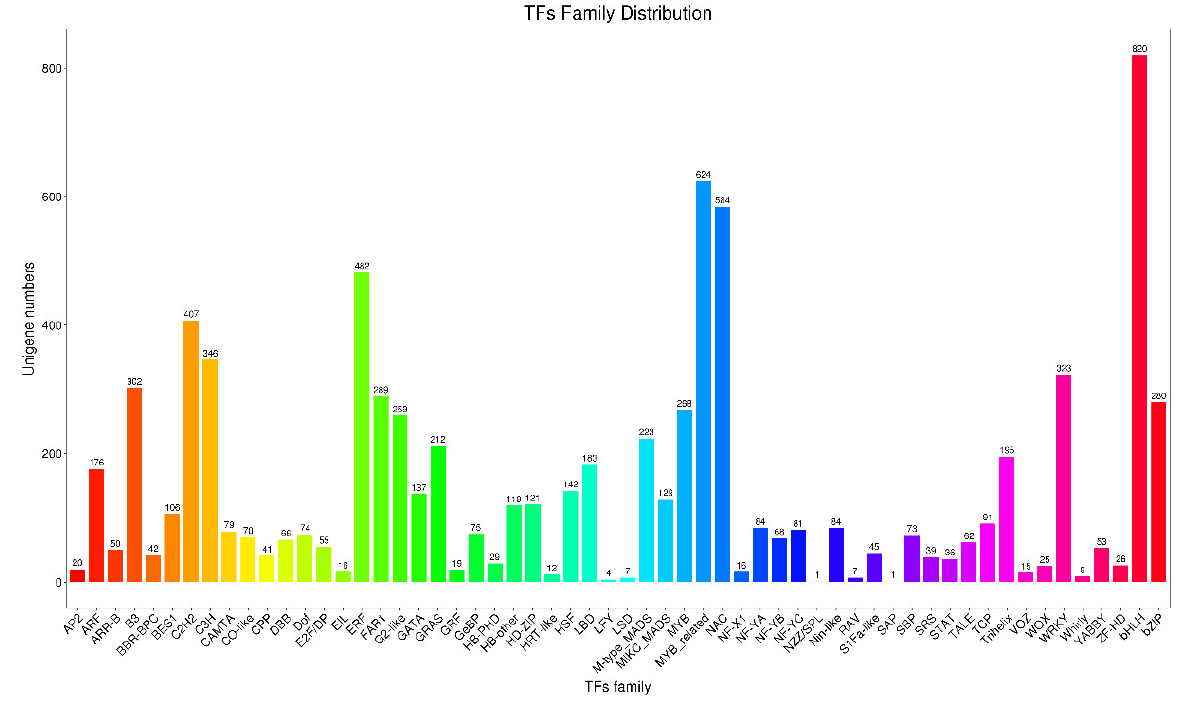
Plants 2022 , 11 , x FOR PEER REVIEW Figure 6. The distribution of TFs family. Figure 6. The distribution of TFs family.